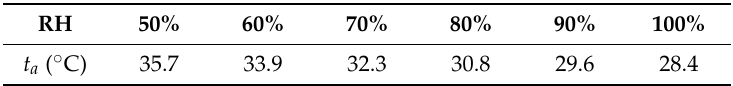
Table 4. The upper limits of temperature and humidity for protection time of 96